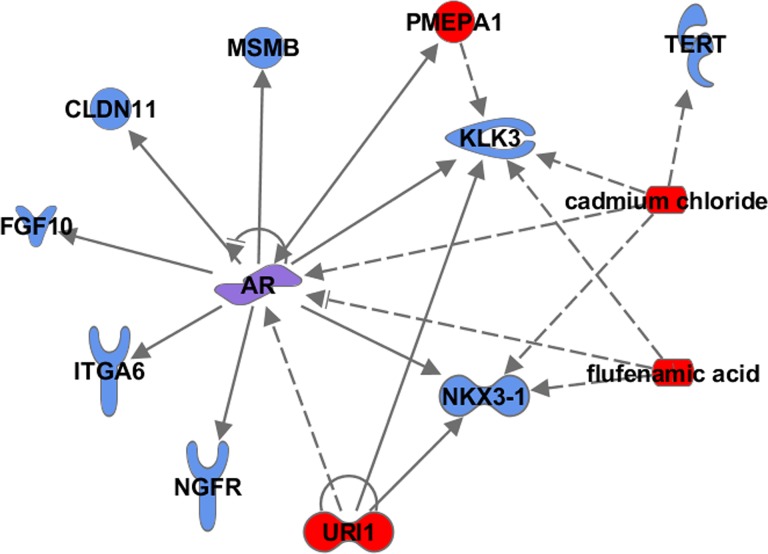
Upstream regulators among genes neighboring SNPs in high LD with prostate cancer risk alleles.The IPA Upstream Regulator tool was used to identify potential upstream regulators based on the statistical significance of genes in the gene list that function downstream of this regulator. The top 5 upstream regulators identified were flufenamic acid, androgen receptor (AR), cadmium chloride, prostate transmembrane protein, androgen induced 1 (PMEPA1), and prefoldin-like chaperone (URI1). Upstream regulators (red); upstream regulator and on the gene list (purple shading); genes from the gene list (blue).